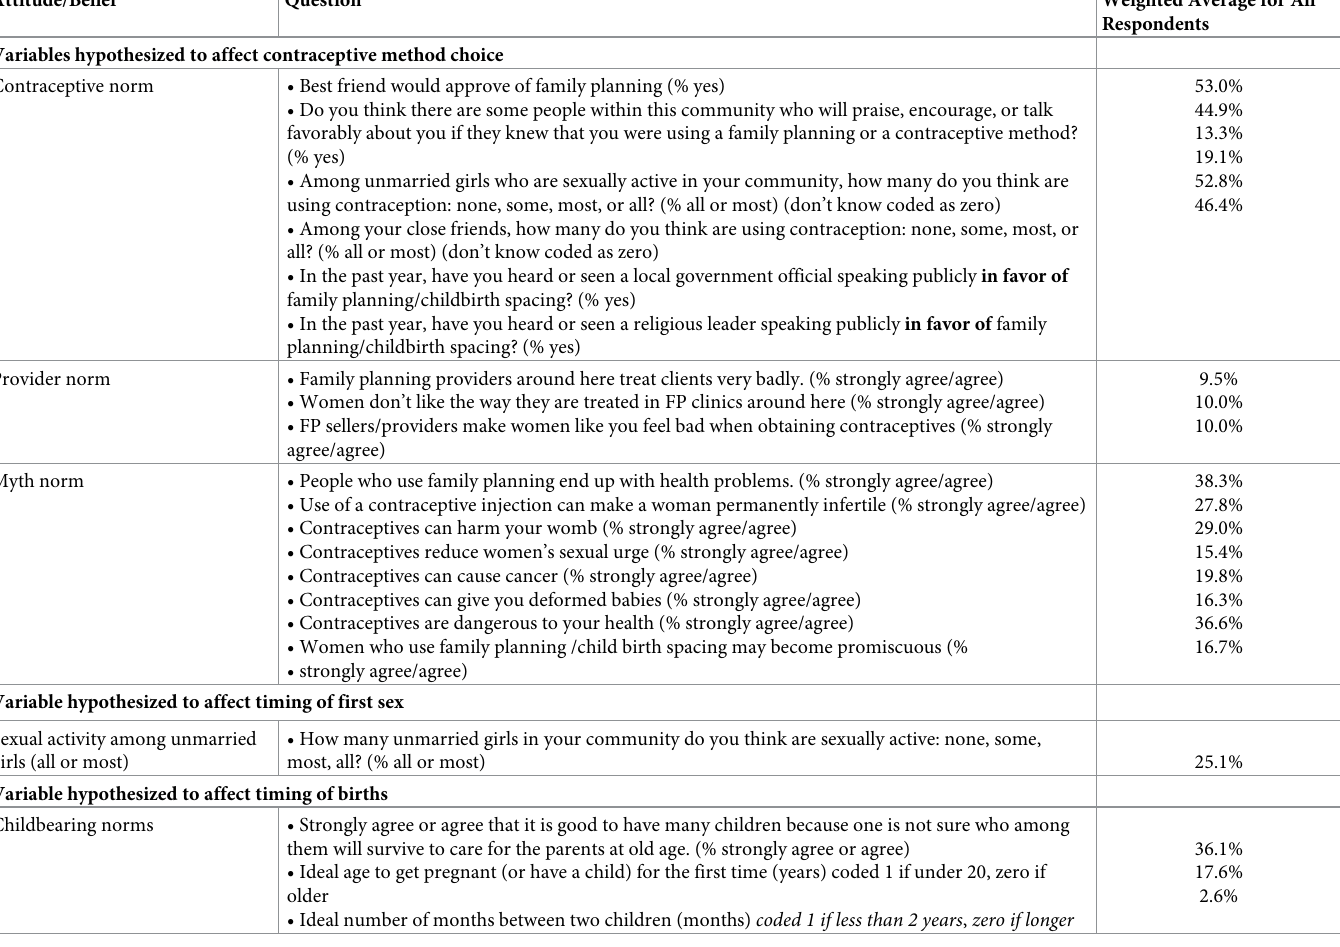
Table 2. Community beliefs and attitudes variables among all female respondents ages 15–49 in three cities in